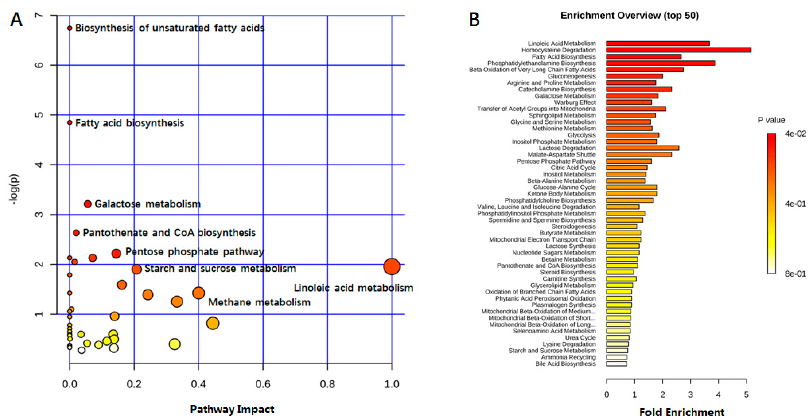
Figure 5. Altered metabolic pathway in MCAO rats as ( A ) visualized by bubble plots and ( B ) enrichment overview.